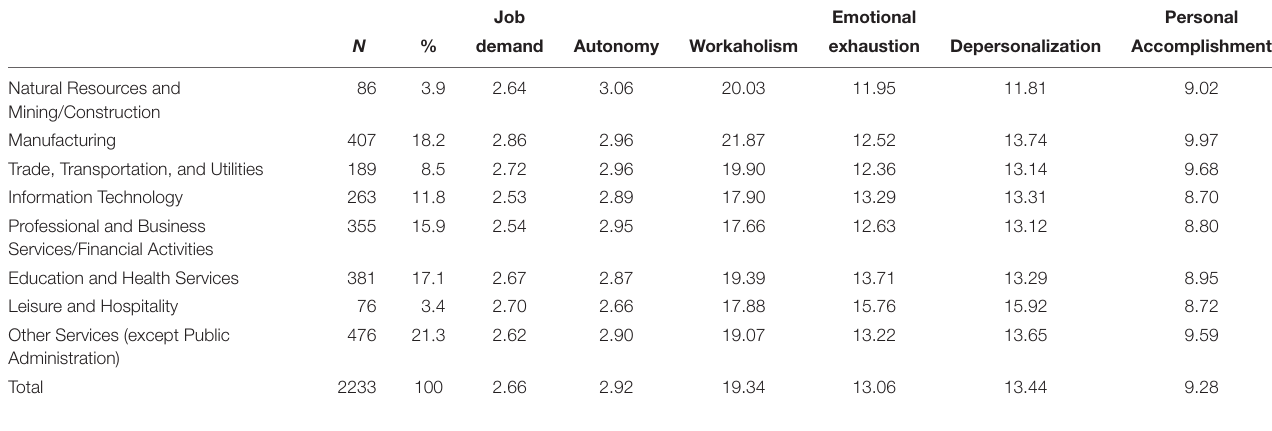
TABLE 1 | Analysis with type of